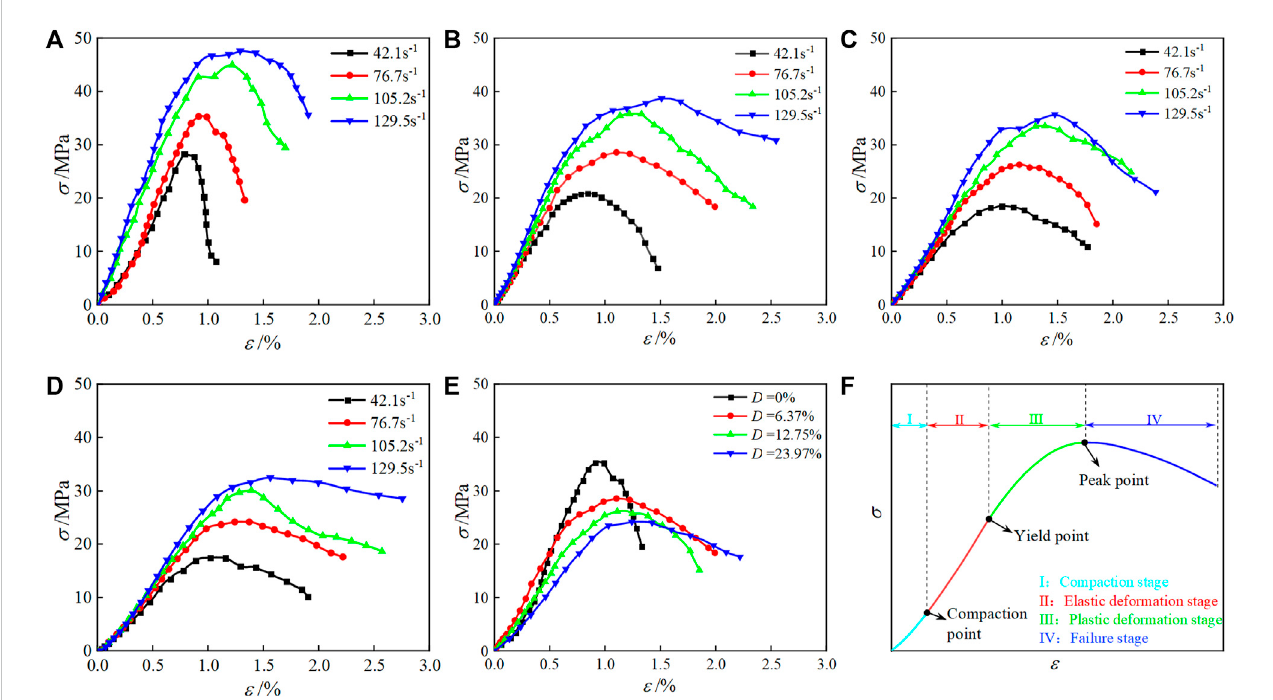
FIGURE 3 Dynamic stress-strain curves of frozen sandstone with initial damage: (A) D =0%; (B) D =6.37%; (C) D =12.75%; (D) D =23.97%; (E) _ ε =76.7s -1 ; (F) Typical curve.